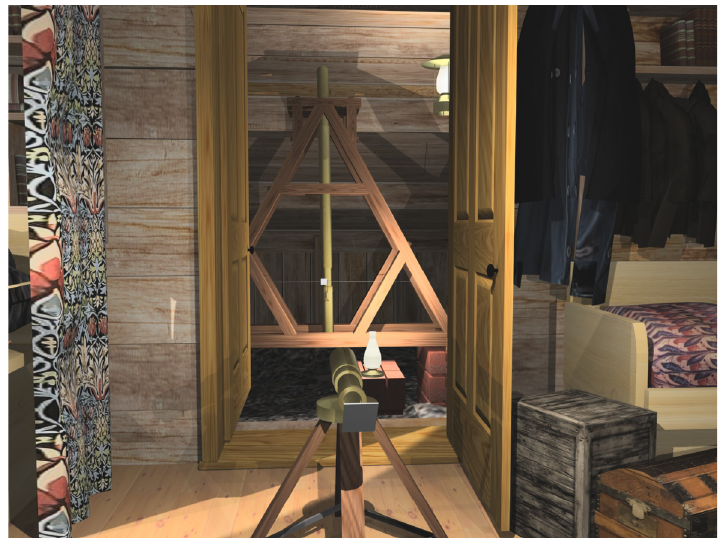
Figure 14. The pendulum’s location within the Greely station